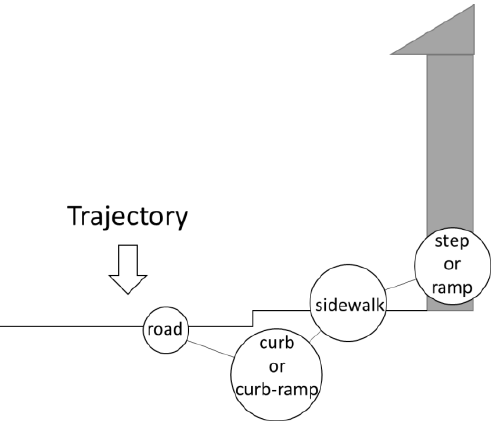
Figure 8. Adjacency relations between floor elements and the trajectory.